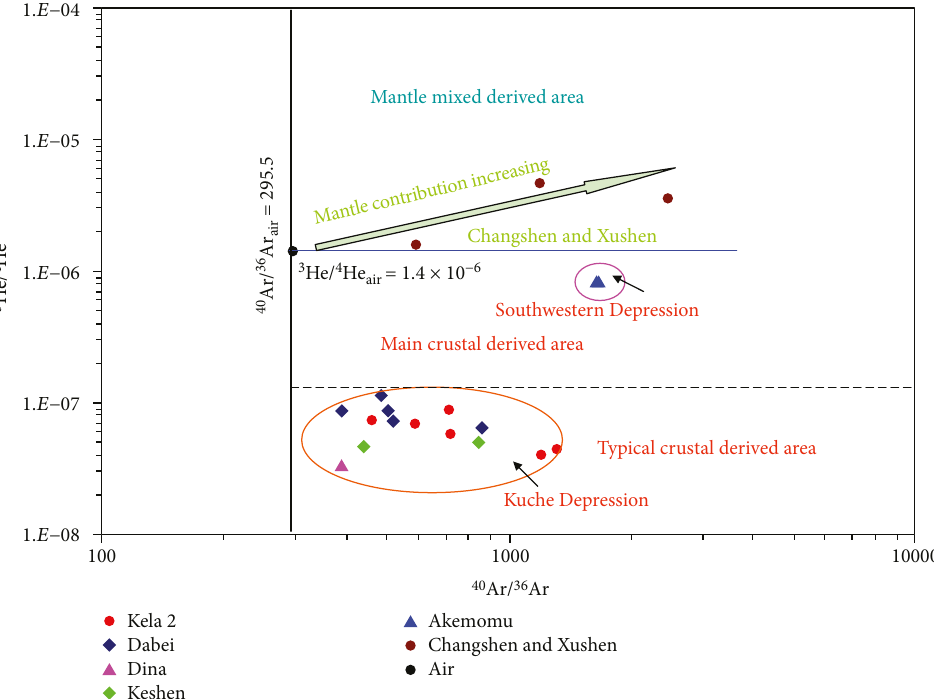
Figure 8: Genetic identi fi cation of 3 He/ 4 He- 40 Ar/ 36 Ar for some gas fi elds from the Kuche and Southwestern Depressions, Tarim Basin (chart modi fi ed from